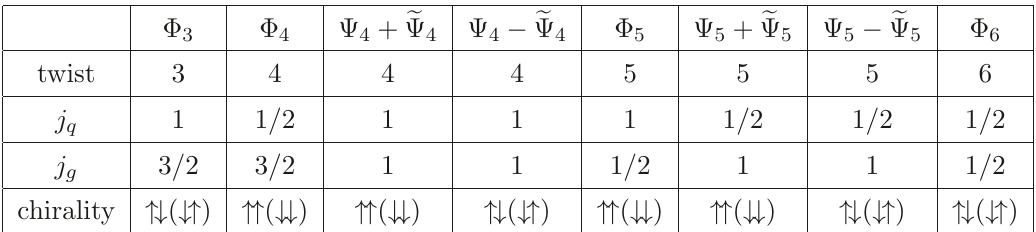
Table 1 . The twist, conformal spins j q , j g of the constituent fields and chirality [same or opposite] of the three-particle B-meson